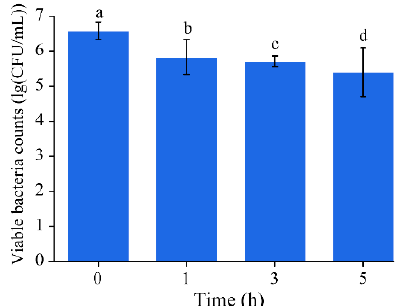
Figure 4. Survival of DMST-H2 in simulated gastrointestinal conditions. Significance was set as p